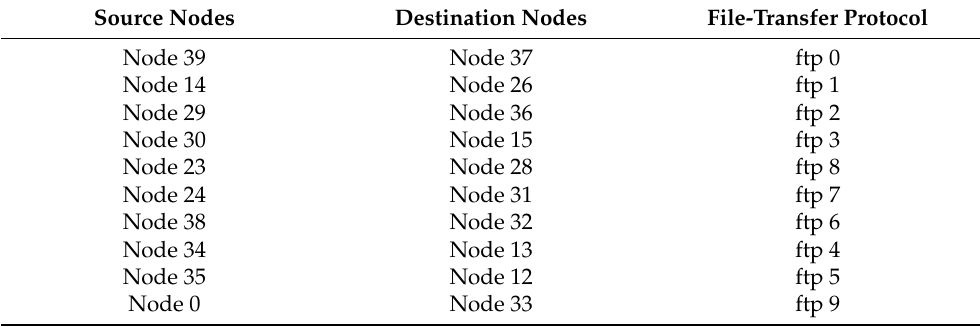
Table 2. Demonstrates configuration connections between the source and destination nodes.